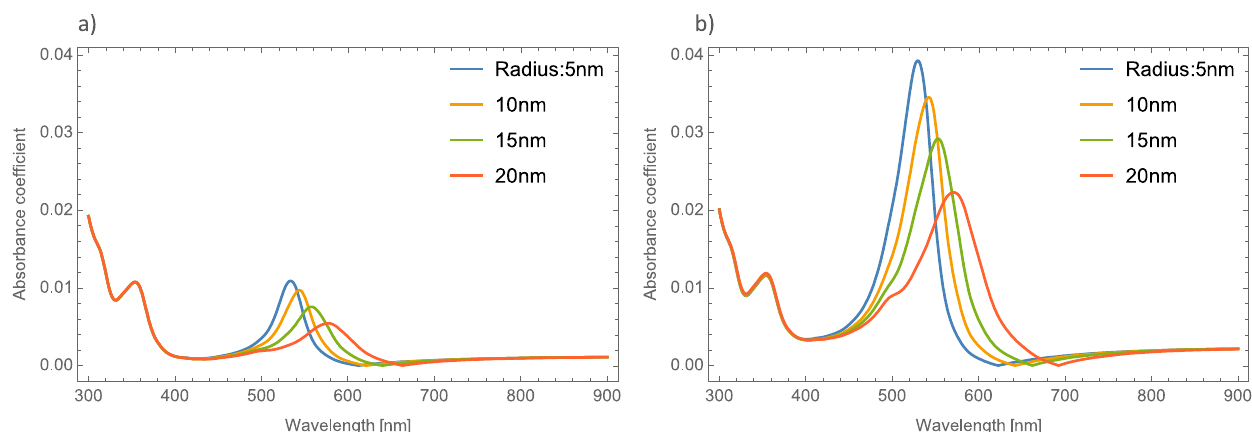
Figure 4. Absorbance coefficient of the MoO 3 thin film doped with Ag ‒ NPs with a thickness value of 120 nm, ( a ) volume filling fraction of 1% and ( b ) volume filling fraction of 5%. The different NPs radii are indicated.